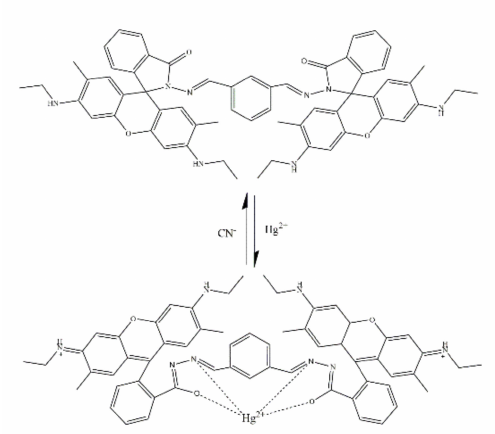
Figure 10. The proposed sensing mechanism of RD6 (Table 1, No.13) to Hg 2+ [45]. Li M., et al. constructed a novel rhodamine-based material, FFC, for the detection and adsorption of Hg 2+ (Table 1, No. 14) [46]. The cellulose was chosen as the skeleton and the rhodamine moiety was conjugated with cellulose as the recognition group, enabling excellent optical signals in the presence of Hg 2+ . After adding Hg 2+ , the intensity of fluo- rescence enhancement of FFC showed a 7-fold enhancement by triggering the spirolactam ring-opening reaction. The adsorption process of FFC to Hg 2+ was fitted with the Langmuir adsorption model and pseudo-second-order kinetics. The prepared FFC was successfully applied for the detection and adsorption of Hg 2+ in tap water. Liang F. et al. introduced an anthocyanin functional group in the rhodamine spiro ring and constructed a sensitive and selective near-infrared (NIR) fluorescent sensor, CCS-Hg for Hg 2+ (Table 1, No. 15) [47]. The prepared CCS-Hg was applied to determine Hg 2+ distribution in living cells. The sensing mechanism was verified through theoretical calculations (Figure 11).